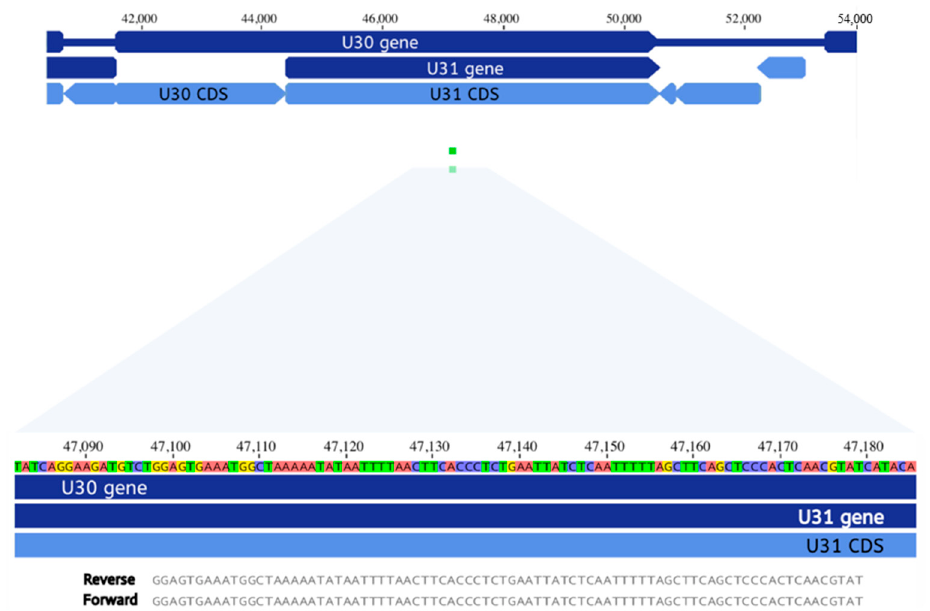
Figure 2. Identification of human herpesvirus 7 DNA in CSF by mNGS. The HHV7 nucleotide sequence includes 144,861 bp. The genome encodes ~100 open reading frames (ORFs). U30 includes 2816 bp; it is a capsid assembly protein. U31 includes 6179 bp, including the read from the mNGS of patient 13; it is a tegument protein. U = ORF located in the unique portion of the genome.